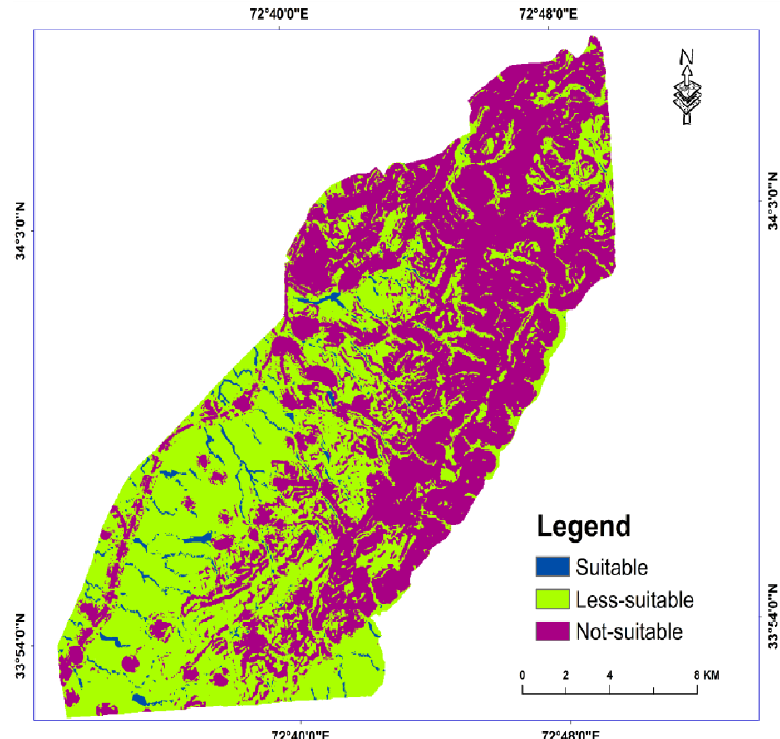
Figure 11. Potential sites for check dams.